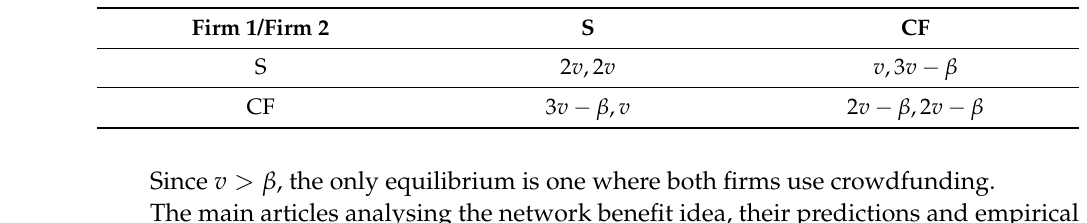
Table 4. Matrix of payoffs 2.